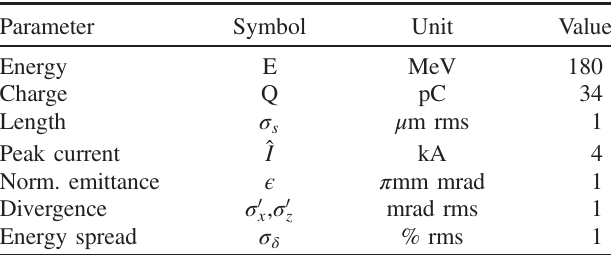
TABLE I. Electron beam parameters at the LPA source point. Norm. stands for normalized. In the six dimensions, the beam is assumed Gaussian and with a cylindrical symmetry along the longitudinal axis.